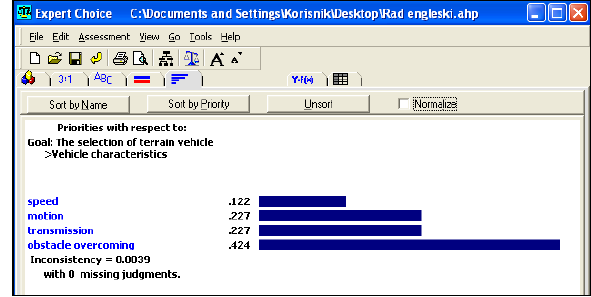
Figure 5. Vehicle